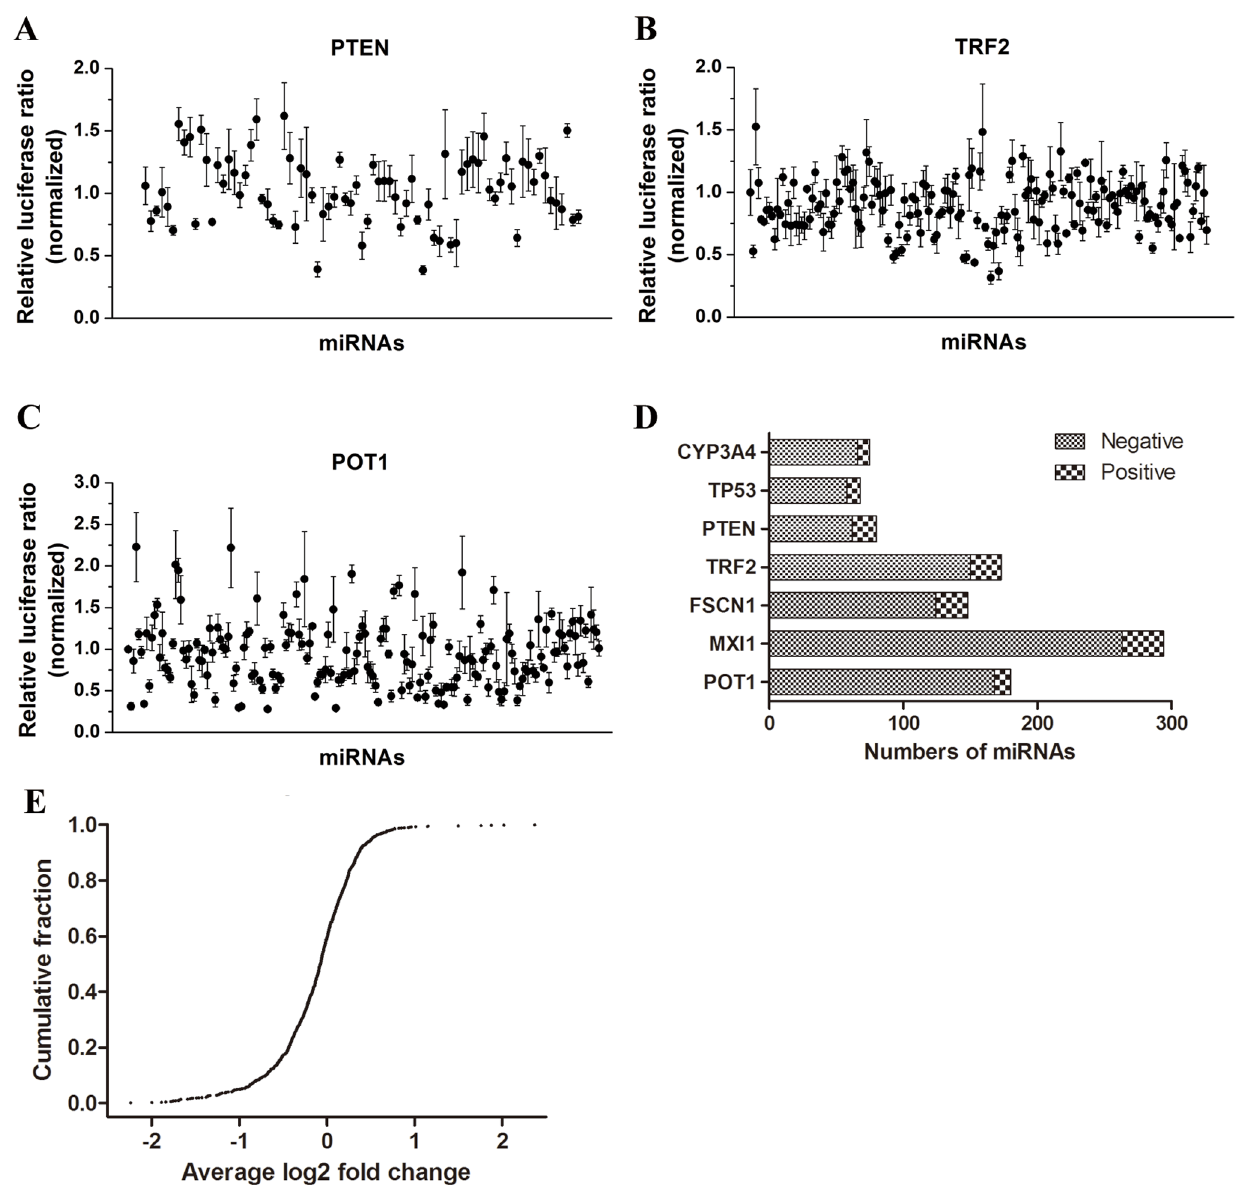
Figure 3. Validation of the predicted interactions for seven genes. (A–C) Co-transfection of 0.15 m g of the pre-miRNA expression vector and 0.05 m g of the luciferase reporter vector containing the full length 3 9 UTR of PTEN (A), TRF2 (B) and POT1 (C) into 293T cells to valid the predicted interactions, with co-transfection of the empty vector of the pre-miRNA and the luciferase reporter containing the same 3 9 UTR as control. The data were normalized to the ratio of Renilla and firefly luciferase activities measured at 48 h post transfection. Values represent the mean 6 S.D. from triplicate transfection experiments. (D) Summary of the results for each gene based on the tested interactions. Inhibitive miRNAs with p , 0.05 were chosen as positive. (E) The cumulative curve showed the distribution of fold changes for all the predicted interactions. Fold changes were calculated according to the negative controls in each experiment. doi:10.1371/journal.pone.0068204.g003 Our analysis showed that EIMMo had the highest prediction precision (27%), and the second was miRDB (24.7%). The lowest precision was observed from PITA (4.3%). The precisions of other prediction tools were 16.2% for TargetScan, 17% for TargetS- canS, 20.6% for DIANA-microT_v3.0, 18.8% for PicTar, 16% for miRanda and 10.9% for NBmiRTar ( Table 1 ).